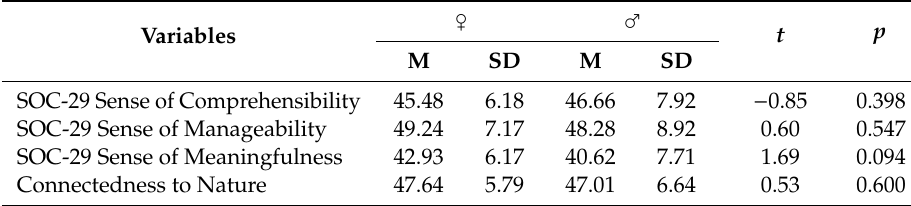
Table 2. Mean results of sense of coherence and connectedness to nature.